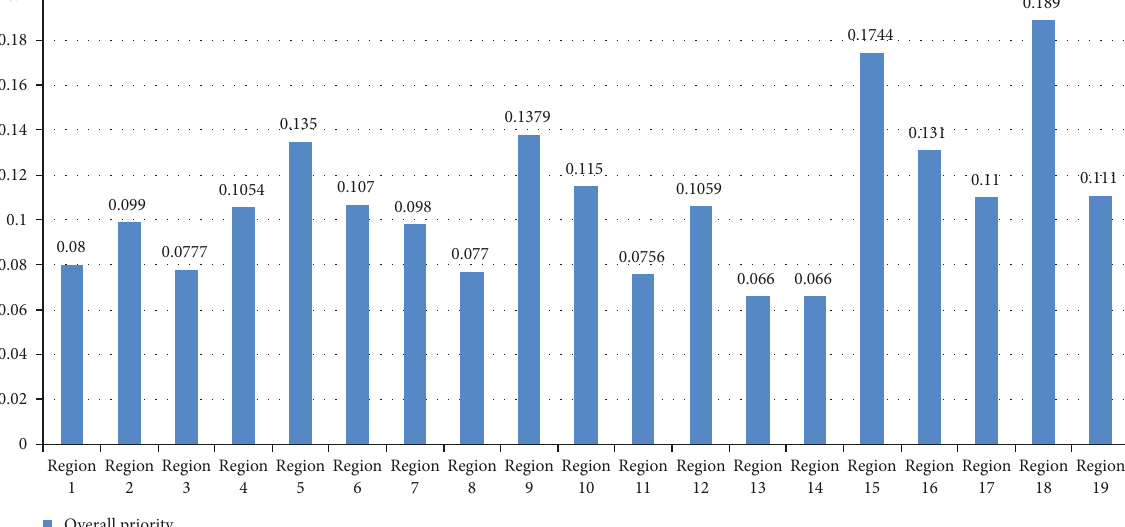
Figure 7: Overall priority of each of 19 districts of Qazvin city for the reversibility criteria after the